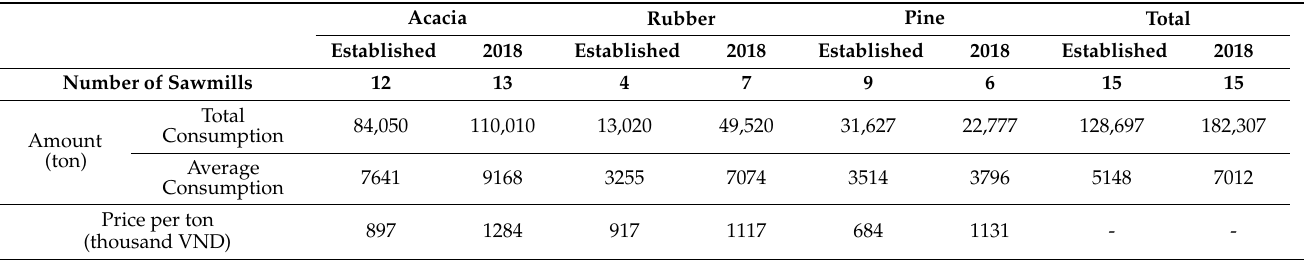
Table 4. Changes in the amount and price of timber consumed by sawmills in Quang Tri Province from establishment to 2019.